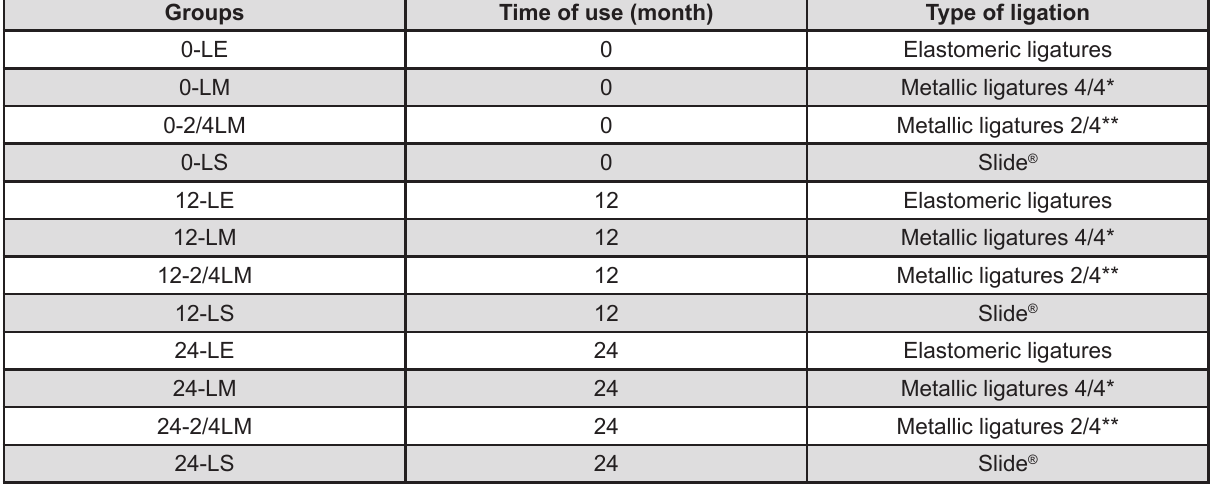
Figure 2- Distribution of brackets and types of wire ligation